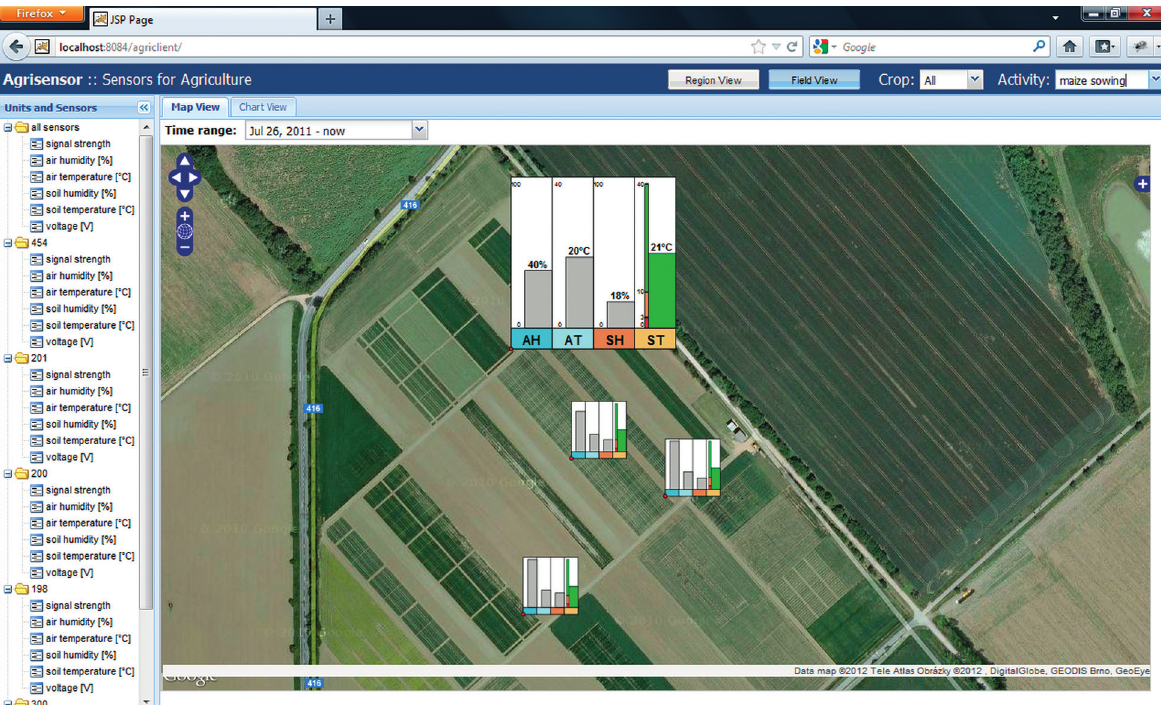
Fig. 5. Multivariate symbol shows air humidity (AH), air temperature (AT), soil humidity (SH) and soil temperature (ST) in specific place of sensor unit. Only soil temperature is important for selected context (maize sowing), so only this part of multivariate symbol is in